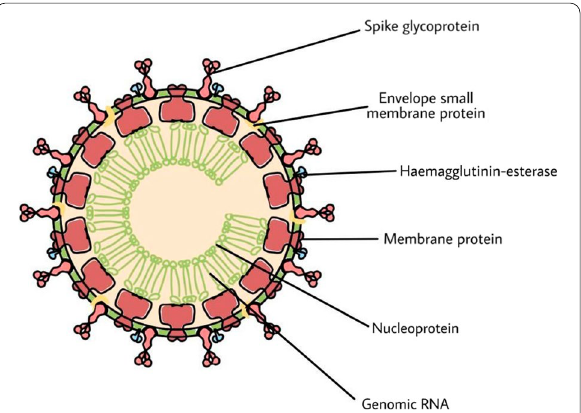
Fig. 4 Structure of novel SARS-CoV-2 (COVID-19